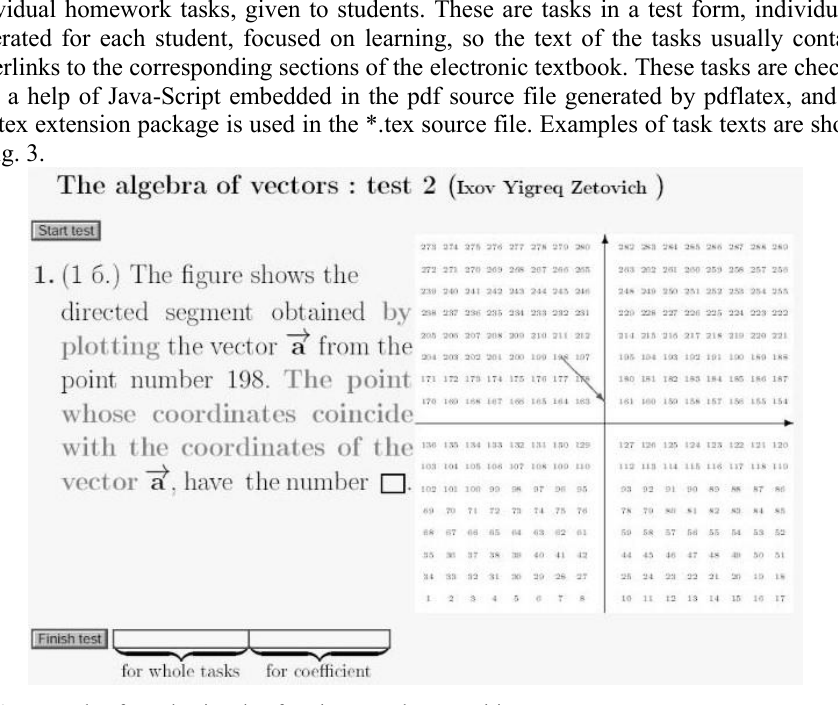
Fig. 3. Example of a task, aimed at forming a goal